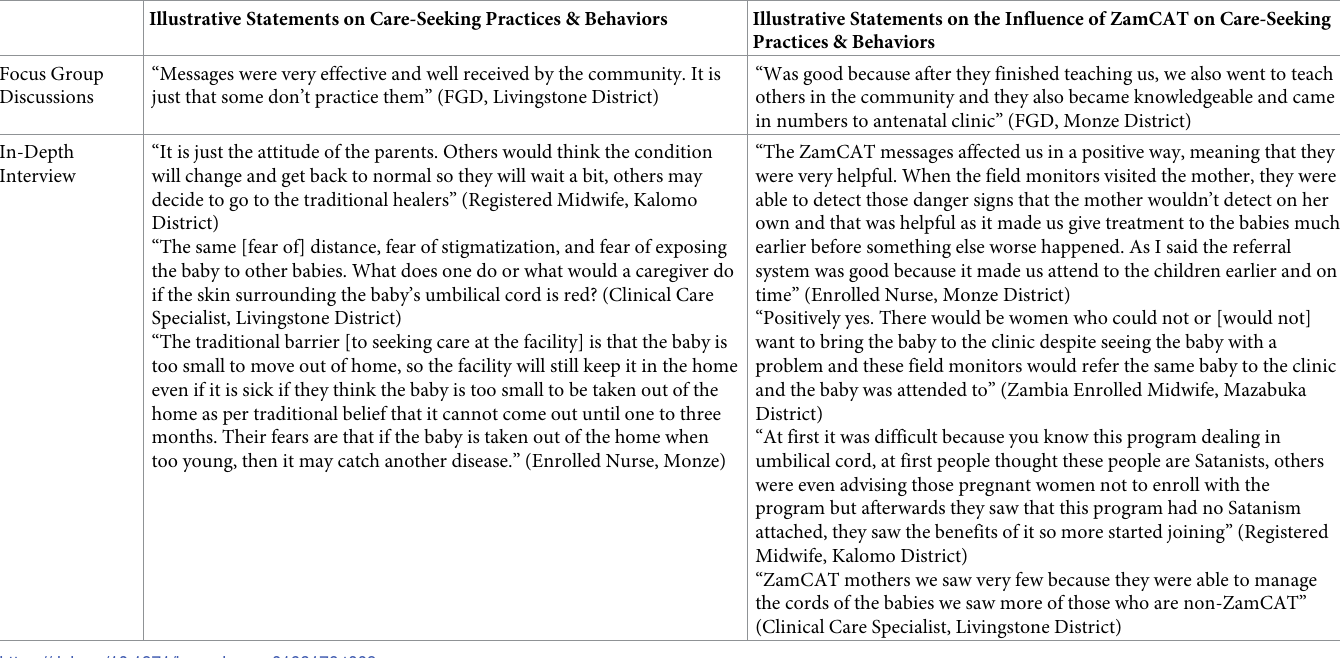
Table 3. Illustrative statements on care-seeking practices & behaviors and influence of ZamCAT. Illustrative Statements on Care-Seeking Practices &